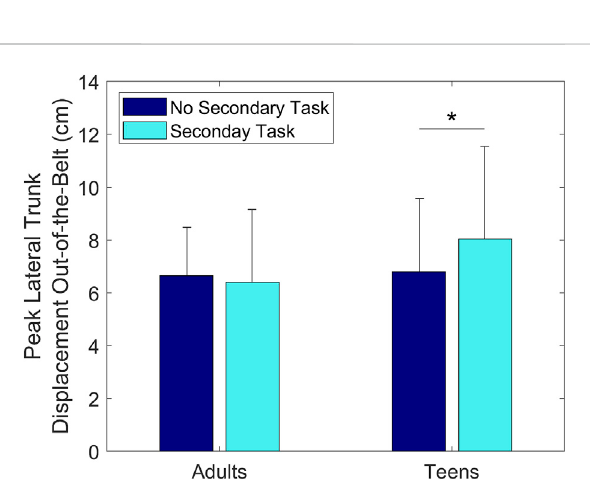
FIGURE 11 Group means ± SD for Peak Lateral Trunk Displacement Out-of- the-Belt for adult and teenage drivers without and with the Secondary